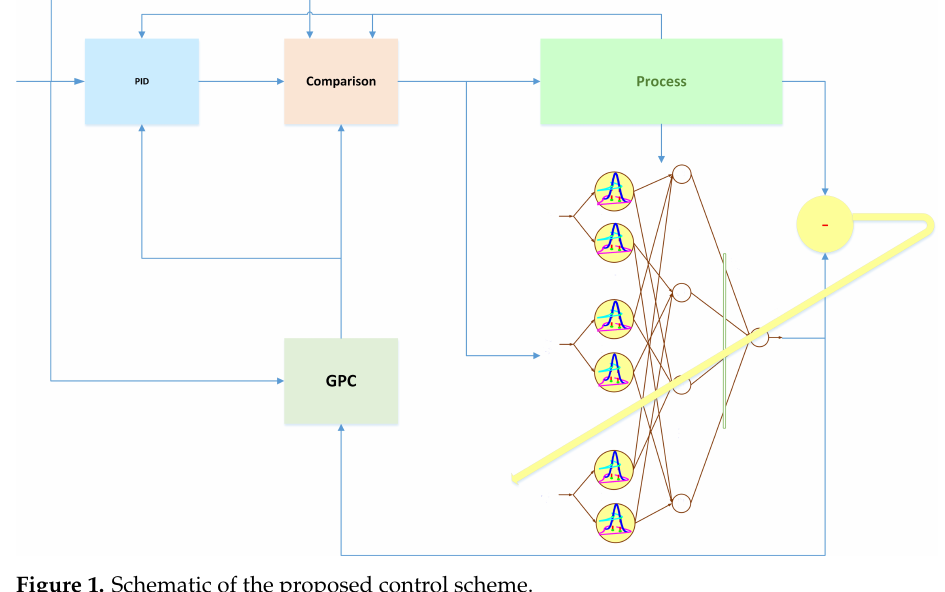
Figure 1. Schematic of the proposed control scheme.